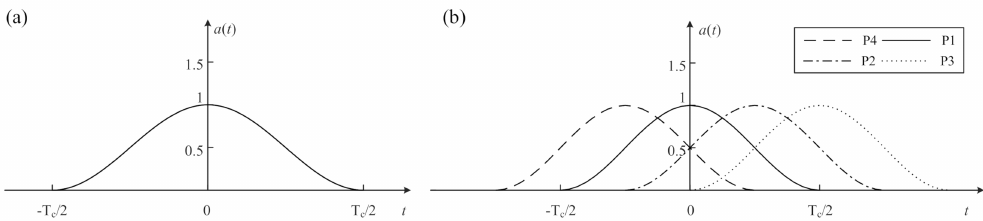
Figure 3. Hanning function-based signal transfer path: ( a ) Hanning function based model of signal transfer path; ( b ) Modulation e ff ect of a four-planet-gear planetary gearbox.